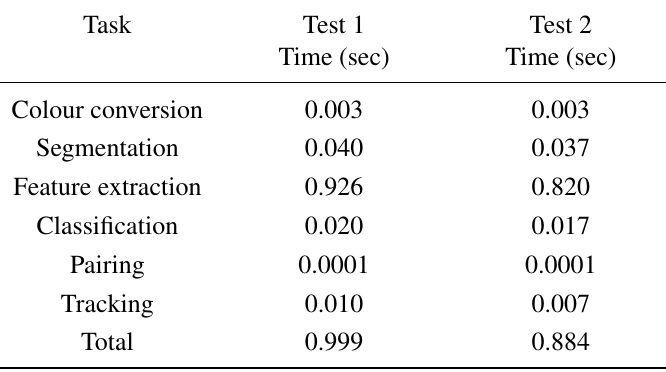
Table 8. Average processing time of different tasks of the